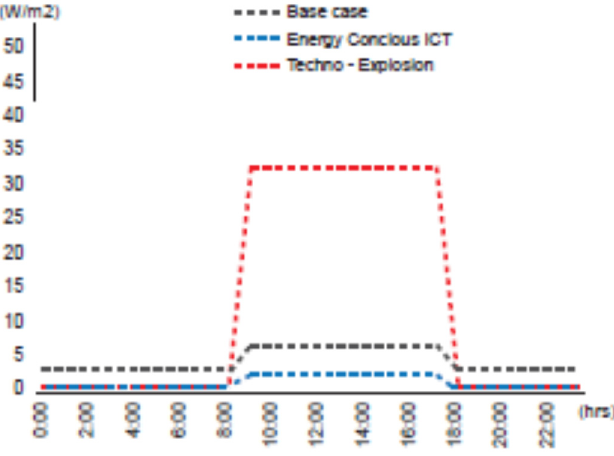
Figure 1. Appliance gains throughout a 24 h cycle in three office scenarios. Source: adapted from Johnson, Counsell, and Strachan [9] and CIBSE